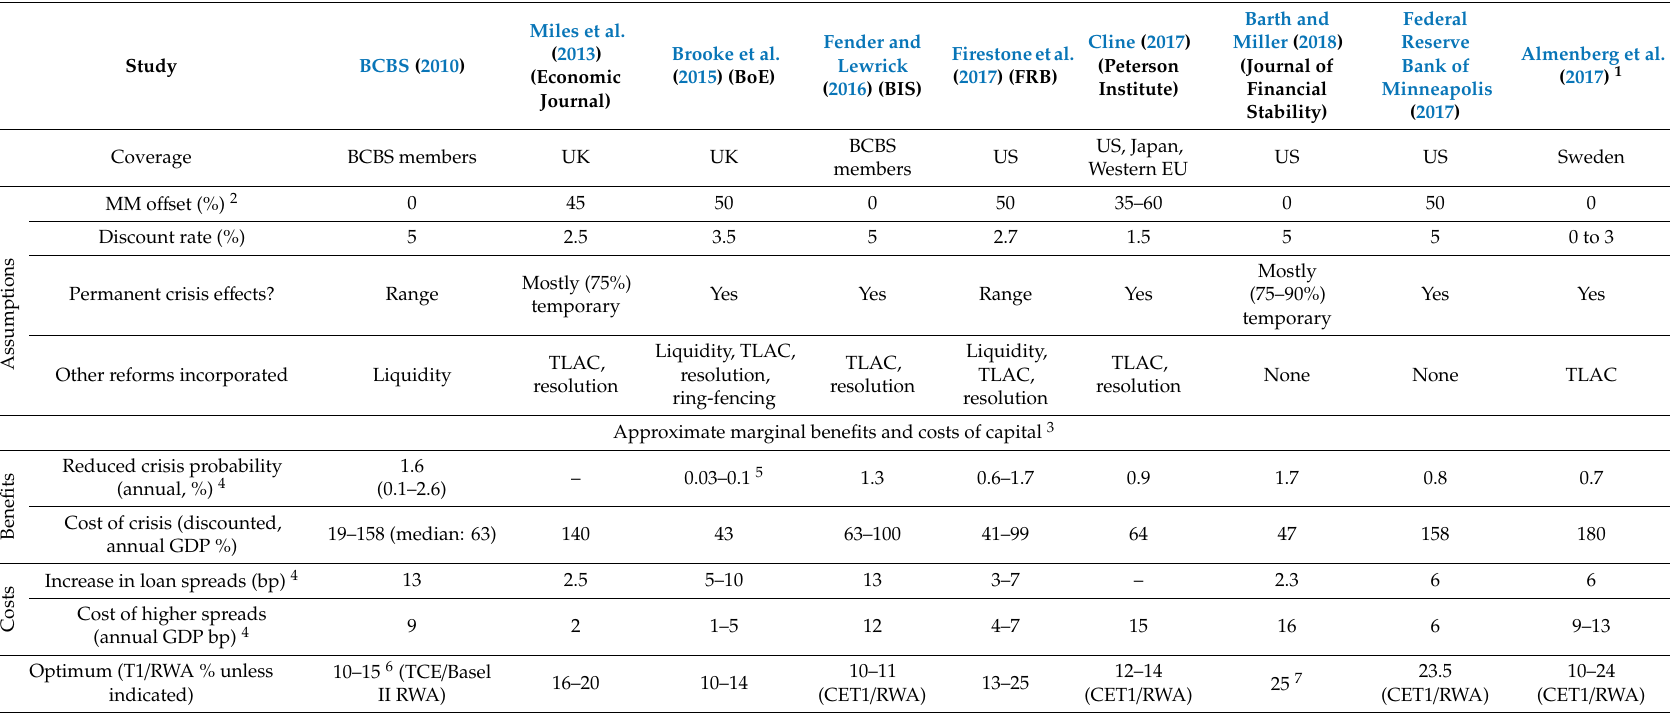
Table 1. Optimal bank capital and components, estimated or inferred, by study: